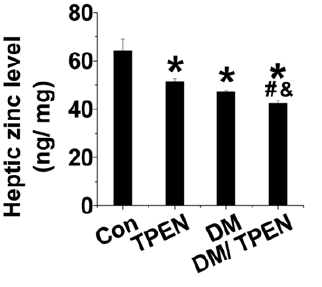
Figure 1. Effect of diabetes and TPEN treatment on hepatic zinc level. Diabetes was induced with MLD-STZ and treated with and without TPEN at 5 mg/kg daily for 4 months. Hepatic Zn levels were measured by atomic absorption spectrometer. Data are presented as mean 6 SD (n=6 at least in each group). DM: diabetes. * P , 0.05 vs. control group; # P , 0.05 vs. TPEN group; & P , 0.05 vs. DM group.